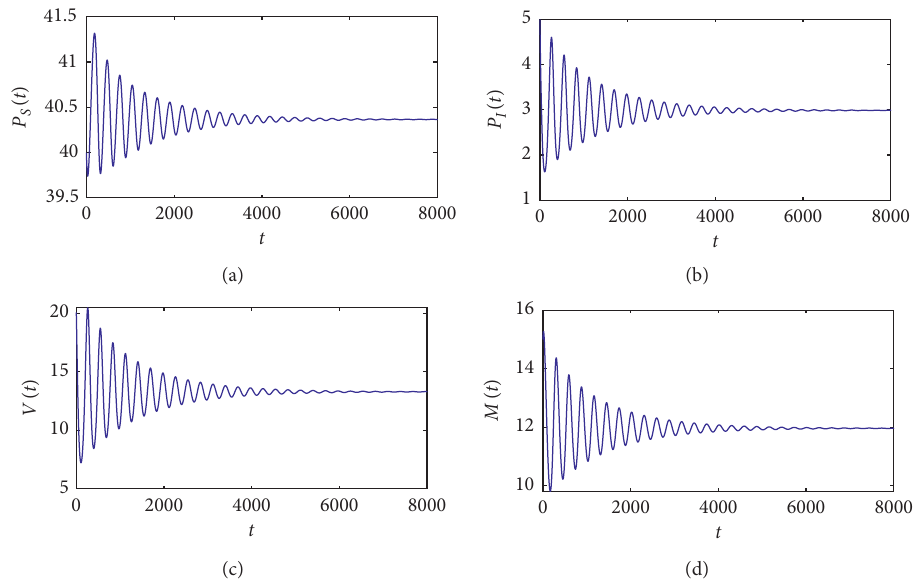
Figure 5: The time series of system (5) when α � 0.95 and τ � 28 < τ 0